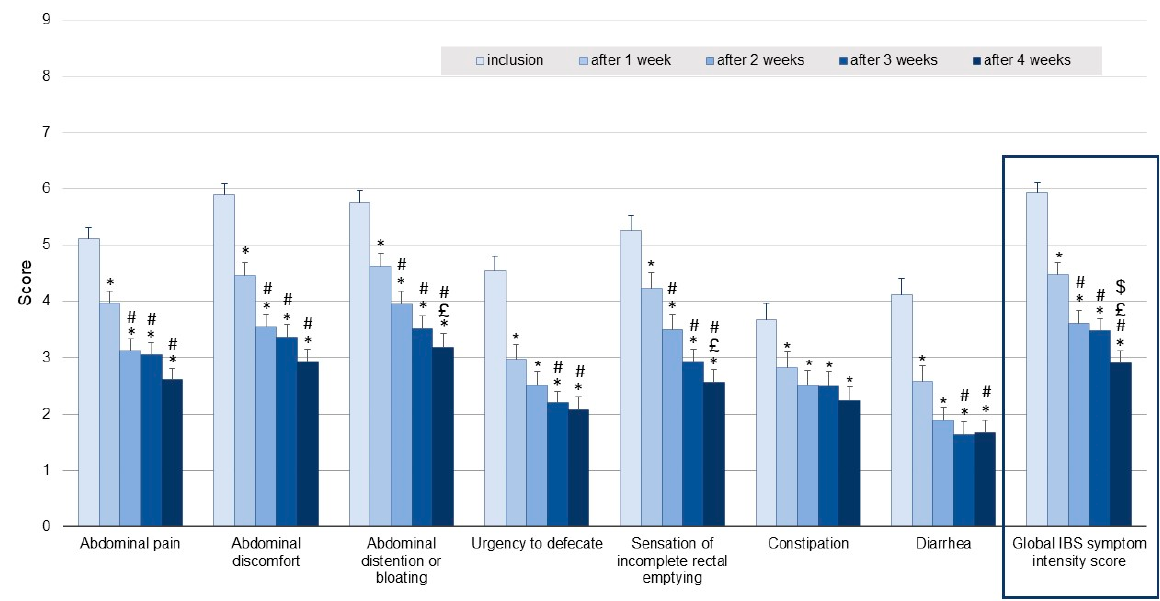
Figure 3. Week-by-week changes in individual and global (box) IBS symptom intensity scores from inclusion to the end of the 4-week supplementation period (mean ± SEM). Assessed by the patients on numeric rating scales (NRS). * p < 0.05 compared to inclusion; # p < 0.05 compared to week 1; £ p < 0.05 compared to week 2; $ p < 0.05 compared to week 3.